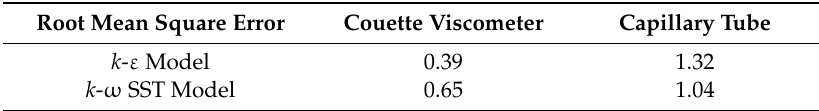
Figure 3. ( a ) Couette viscometer mean velocity profiles near wall for the DNS data of Pirro et al. [60]: solid line, k - ε model: circles, k - ω SST model: triangles; ( b ) capillary tube mean velocity profiles near wall for the DNS data of Chin et al. [59]: solid line, k - ε model: circles, k - ω SST model: triangles. Table 3. Root mean square errors for the Couette viscometer [16] and capillary tube experiments